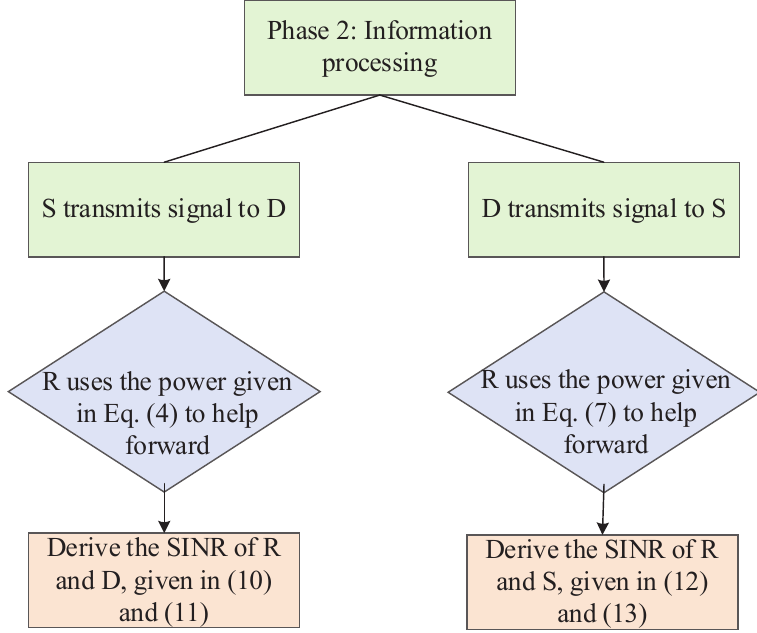
Figure 3. The flow chart of information